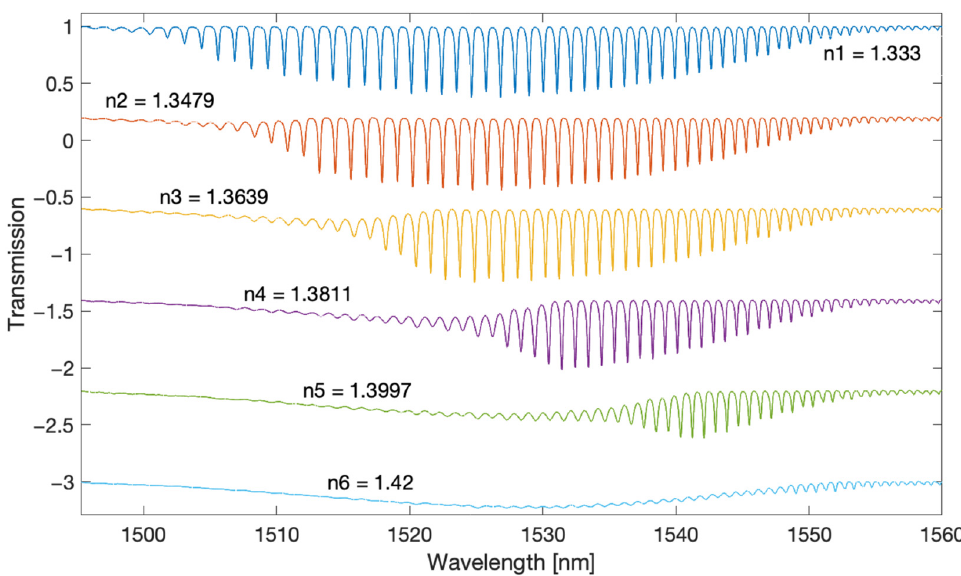
Figure 2. Optical spectrum of the TFBG for several SRI values.